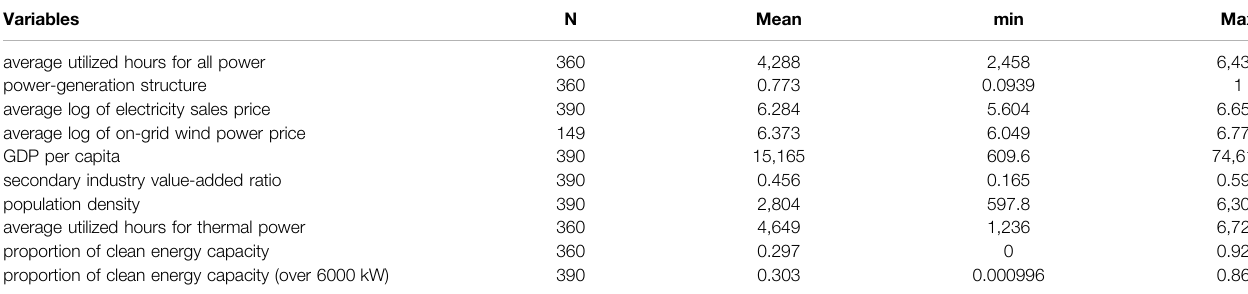
TABLE 1 | Summary statistics. Variables N average utilized hours for all power